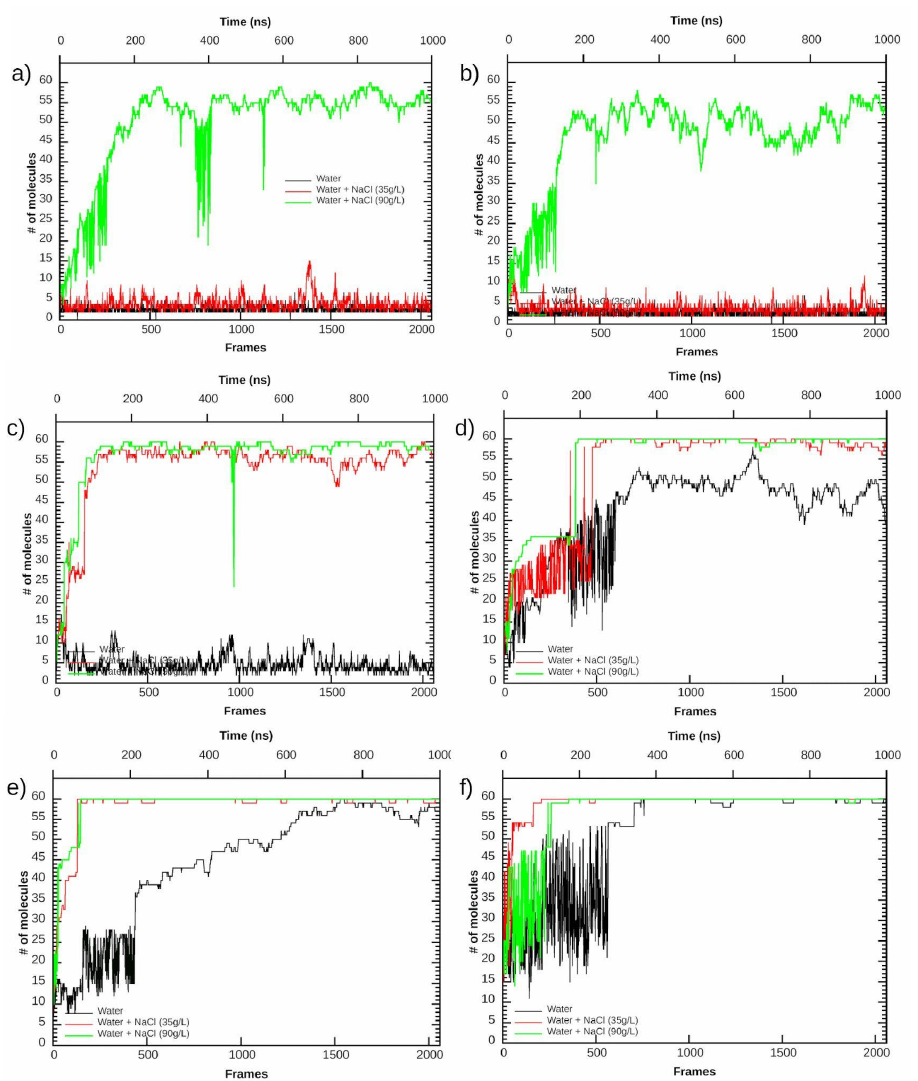
Figure 4. Size of largest aggregate along MD trajectories for different NAs in pure water (black), in low salinity solution (NaCl 35 g/L—red), and in high salinity solution (NaCl 90 g/L—green): ( a ) c9,